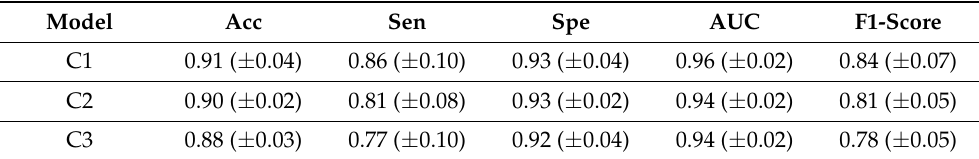
Table 3. Results for the models with K-fold CV for each test set of each fold with the mean results of the models for the 5 folds and the standard deviation.